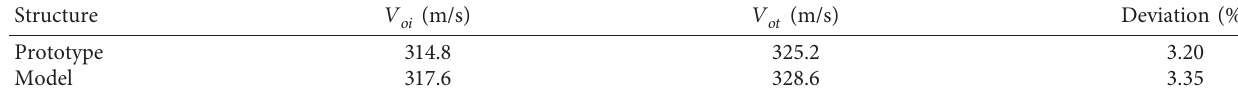
Table 6: Comparison of the initial striking